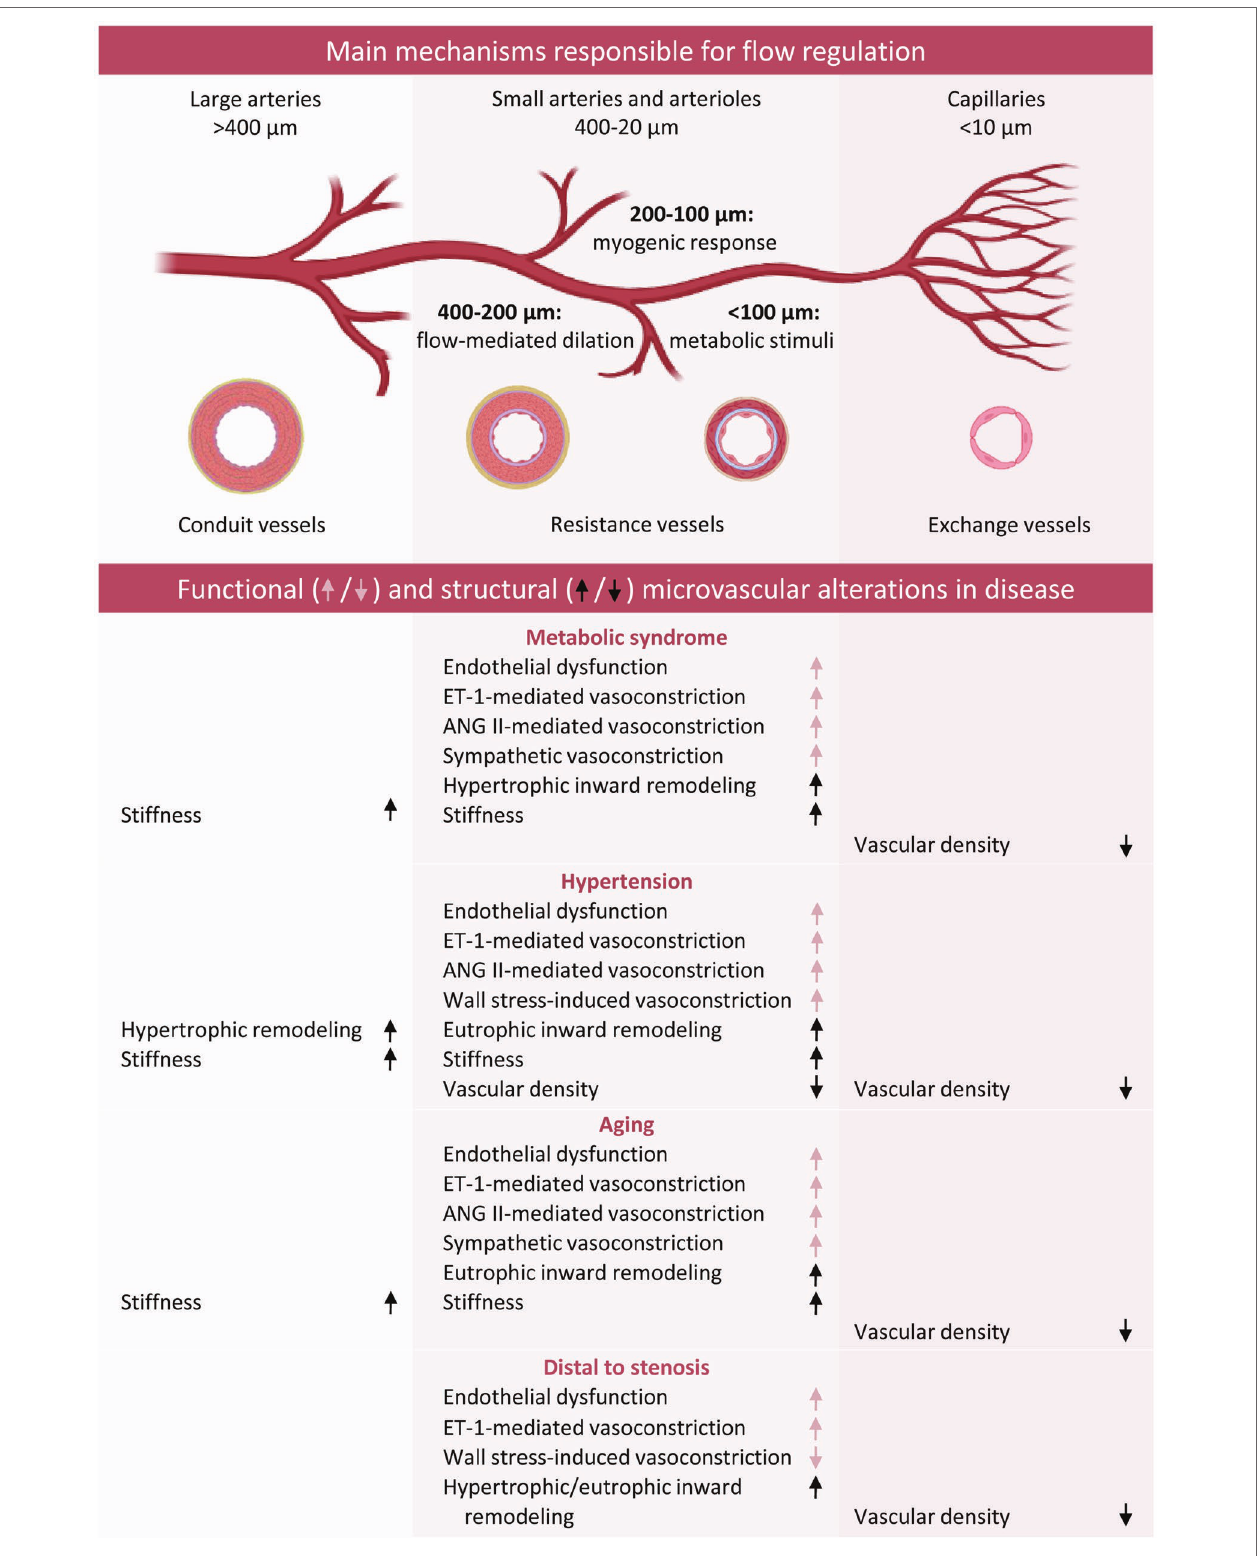
FIGURE 4 | Schematic overview of functional and structural coronary microvascular alterations in the presence of classic risk factors. Red arrows refer to changes in vascular function, whereas black arrows refer to vascular remodeling. ANG II, Angiotensin II; ET-1,